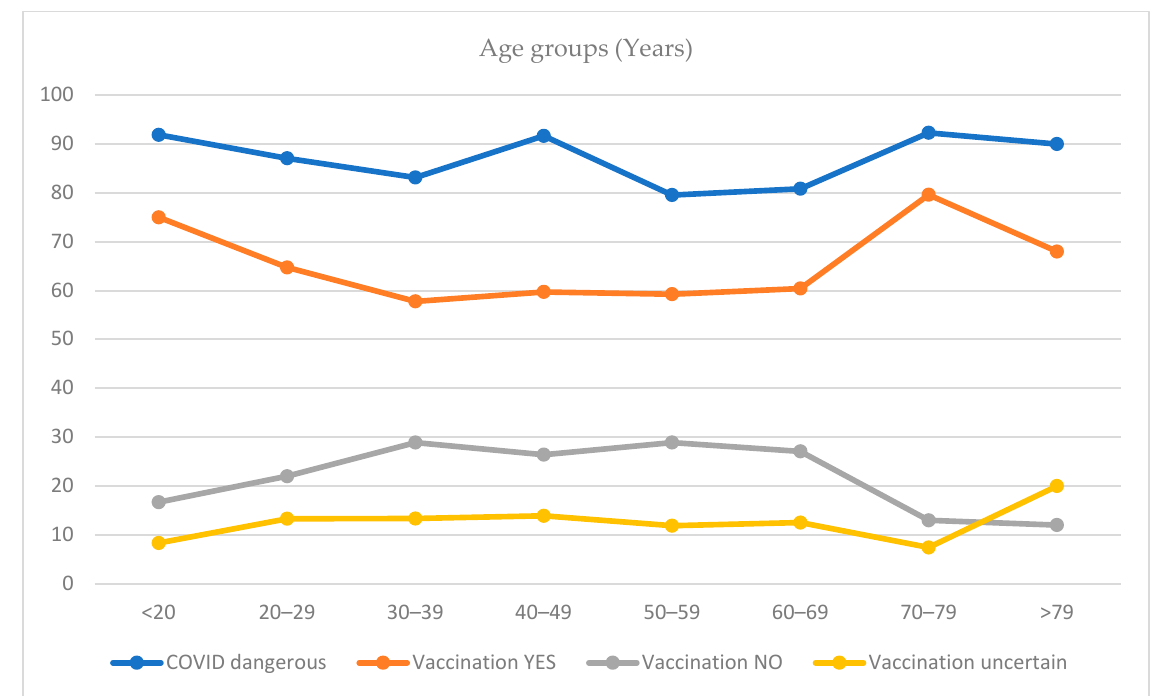
Figure 1. Risk perception and vaccination intention among different age groups.